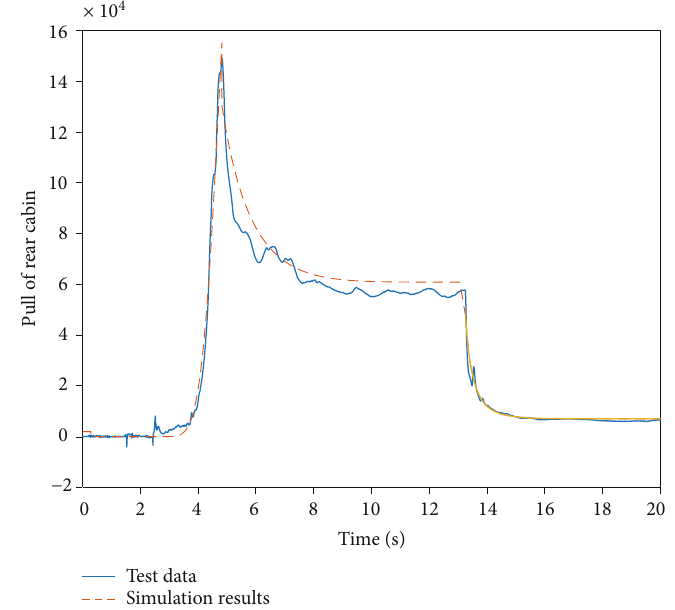
Figure 19: Pull of rear cabin-time